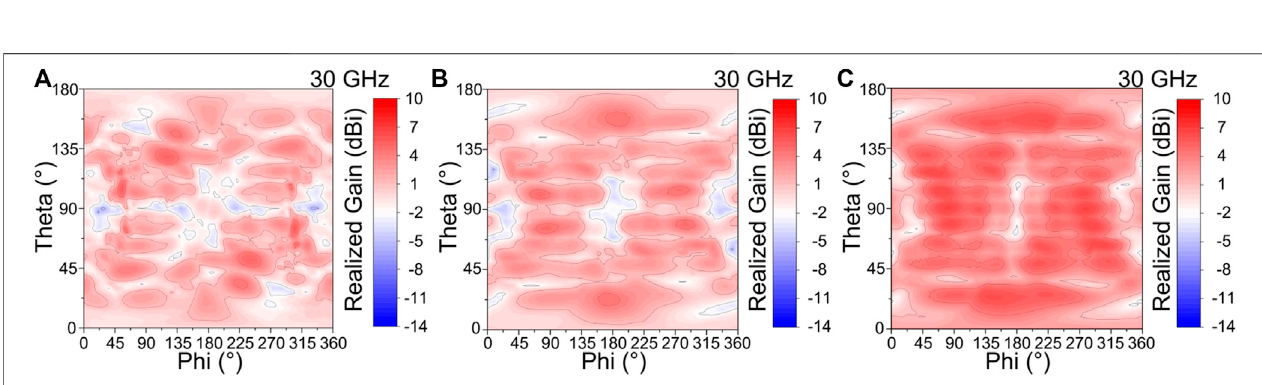
FIGURE 10 | Simulated total scan patterns (26 GHz) of the designed array antennas in the handset mockup. (A) CPW TL. (B) GCPW TL without via fences. (C) GCPW TL with via fences.